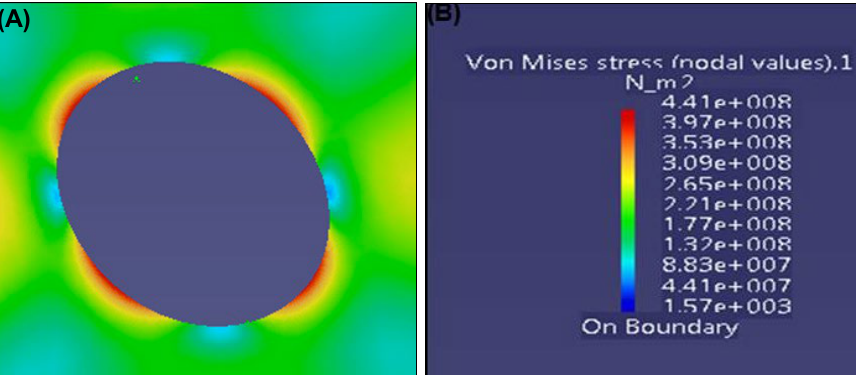
Figure 2. (A) Finite element analysis showing cross-sectional stress distribution in the lateral port hole; (B) List shows the value of each colour and the corresponding units of stress, unit is N.m- 2